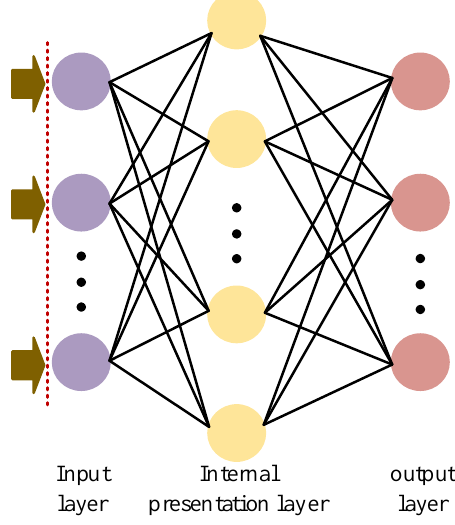
Figure 1. RNN neural network structure diagram.